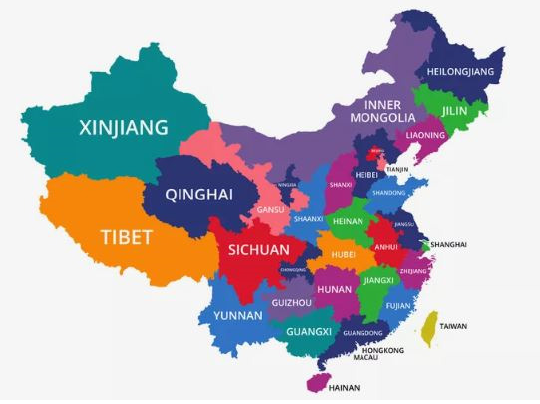
Figure 1. Map of the Chinese territory [33].